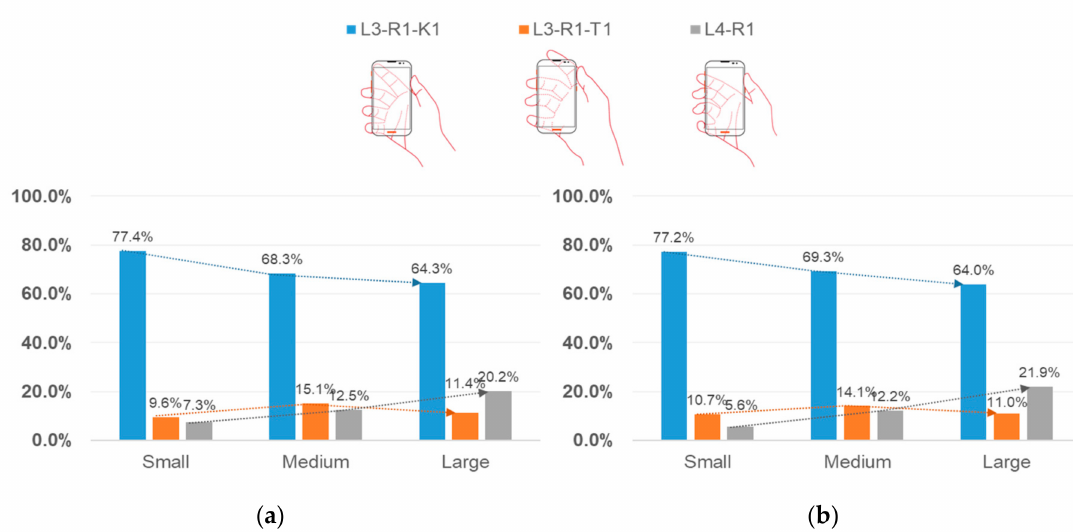
Figure 6. The frequency distribution of grip posture by hand size for hard key operations on a smartphone. ( a ) use frequency distribution of grip posture by hand width; ( b ) use frequency distribution of grip posture by hand